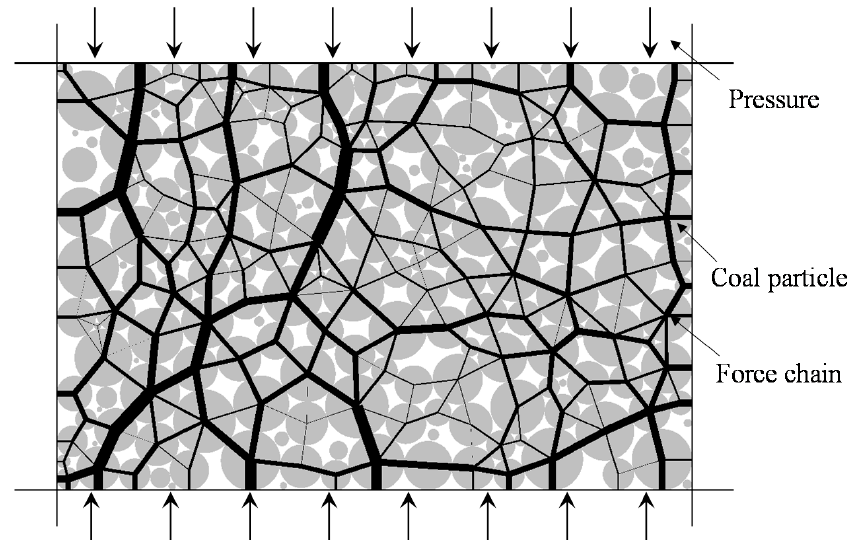
Figure 10. Distribution diagram of contact force between particles under vertical loading .